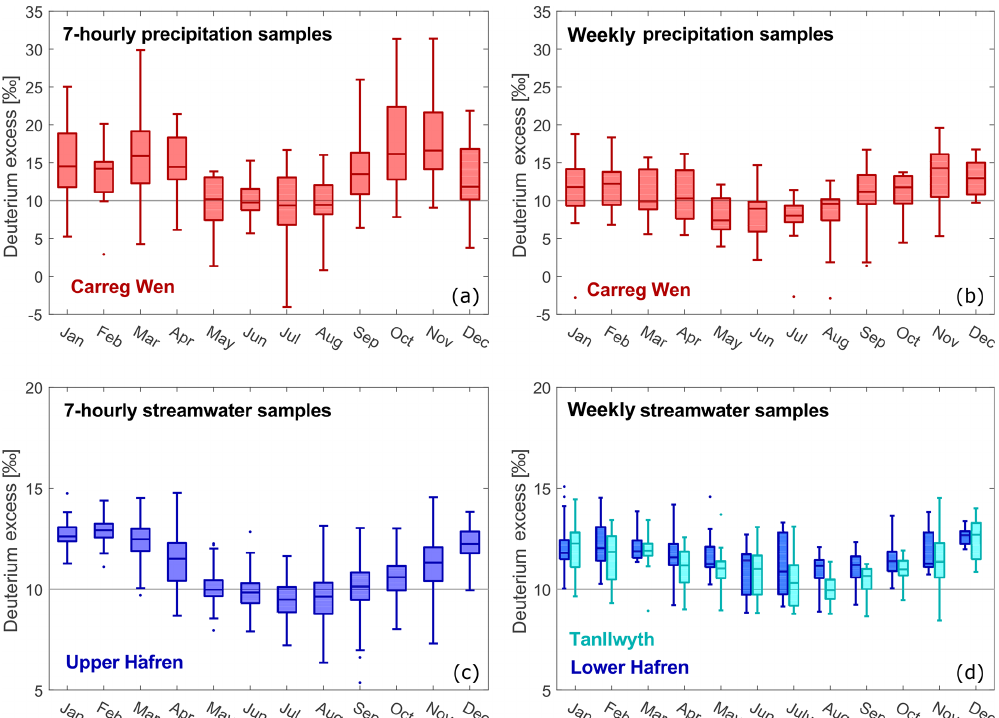
Figure 3. Seasonal variations in deuterium excess for 7-hourly and weekly precipitation samples (a–b) and streamwater samples (c–d) . In each boxplot, the center line indicates the median, whereas the box delimits the 25th and 75th percentiles. Whiskers extend twice the interquartile range, or to the maximum and minimum of the data. Outliers beyond the whiskers are indicated by separate points. Axis scales differ between (a, b) and (c, d) , reflecting the greater variability in precipitation deuterium excess. There are small but distinct seasonal differences in deuterium excess in both precipitation and streamwater. However, the deuterium excess patterns in the 7-hourly streamwater samples mirror those in the weekly grab samples (which were not vulnerable to evaporation in the field), suggesting that these patterns reflect real-world seasonal variations in deuterium excess, and that any evaporative fractionation effects of storage in the 7-hourly samples are